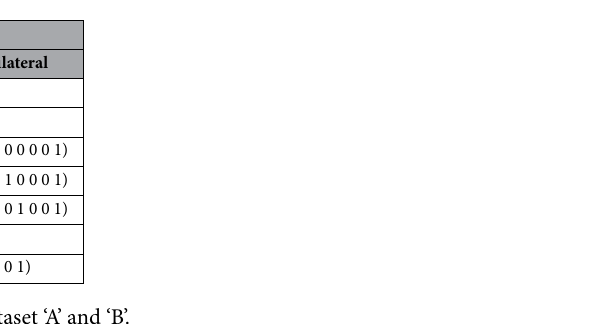
Table 2. Conditional vectors for the dataset ‘A’ and